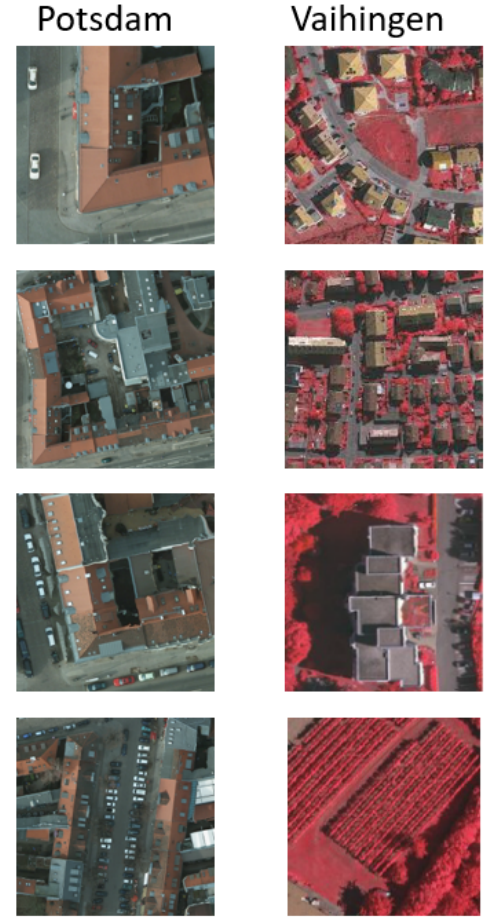
Figure 7. Samples of images from Potsdam and Vaihingen International Society for Photogrammetry and Remote Sensing (ISPRS) datasets.